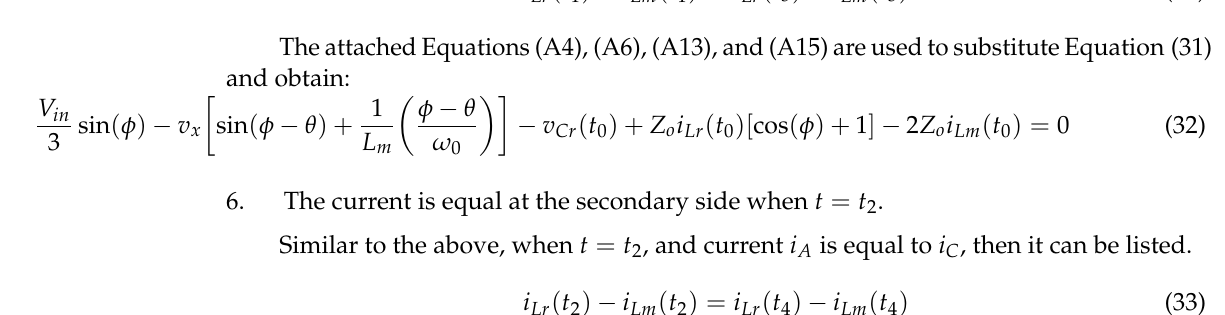
Figure 16. Waveform of transformer current. 6. The current is equal at the secondary side when 𝑡 = 𝑡 (cid:2870) . 6. The current is equal at the secondary side when t = t 2 .